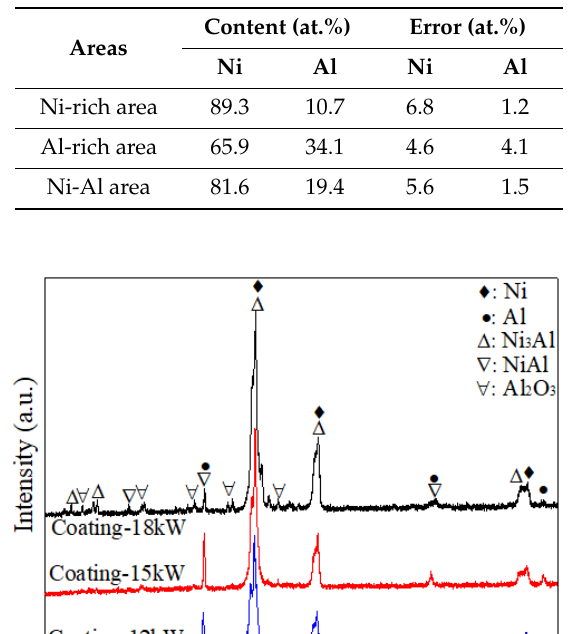
ff erent spraying